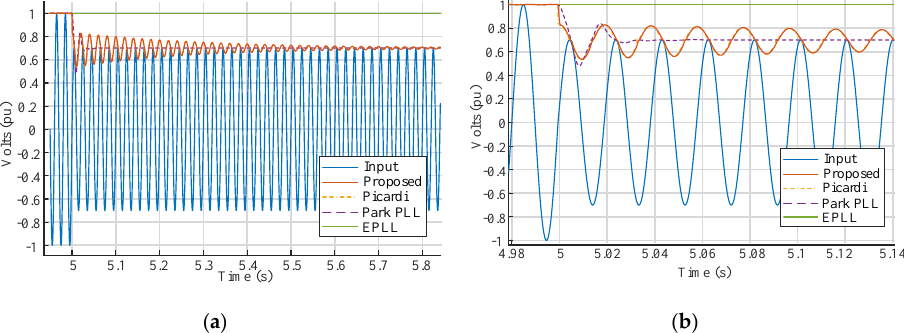
Figure 18. Comparison of amplitude detection techniques for a voltage sag from 1 to 0.7 pu (50 Hz) for ( a ) extended frame; ( b ) zoomed frame.